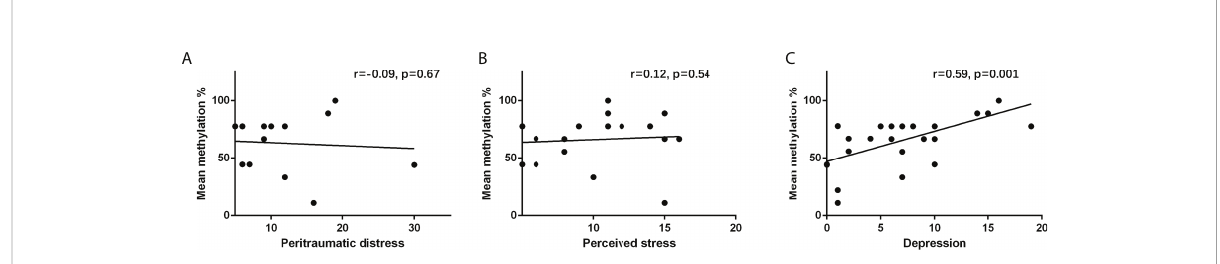
FIGURE 2 Correlation between (A) peritraumatic distress and NR3C1 gene methylation, (B) perceived stress and NR3C1 gene methylation, and (C) depression and NR3C1 gene